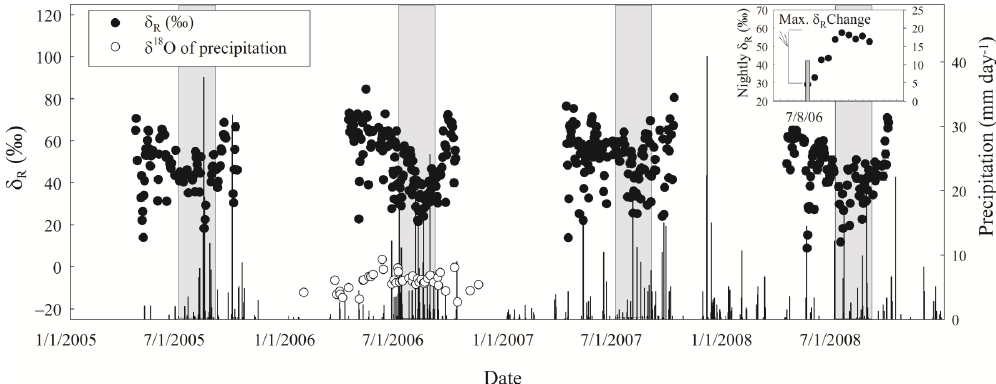
Fig. 2. Annual and seasonal variation in δ R over four years. Precipitation is also shown to facilitate visualization. δ 18 O of precipitation (open circle) for year 2006 is included. Filled boxes represent monsoon periods. An approach to calculate maximum δ R change is visualized as an inset. Table 1. δ 18 O values of leaf water, stem water and soil water in 2005 and 2006. Alphabetic superscripts (a, b, and c) within columns indicate differences among the three groups using Tukey’s test ( F = 225.1, p < 0.001). Different soil depths are denoted as d 2cm, e 5cm, f 7cm, g 10cm, and h 15cm. DOY/Year Day(s) after rain 18 O (SMOW,‰) Juniper foliage a Juniper stem b Soils